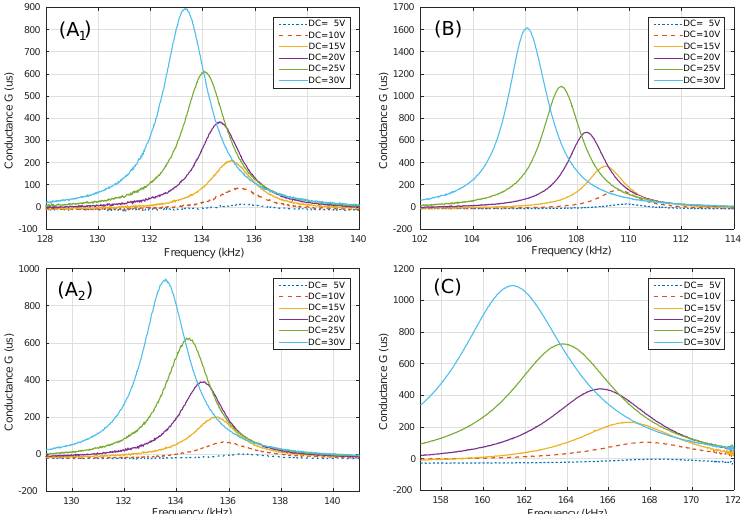
Figure 6. Resonance frequency for each prototype with the best release time between 30–40